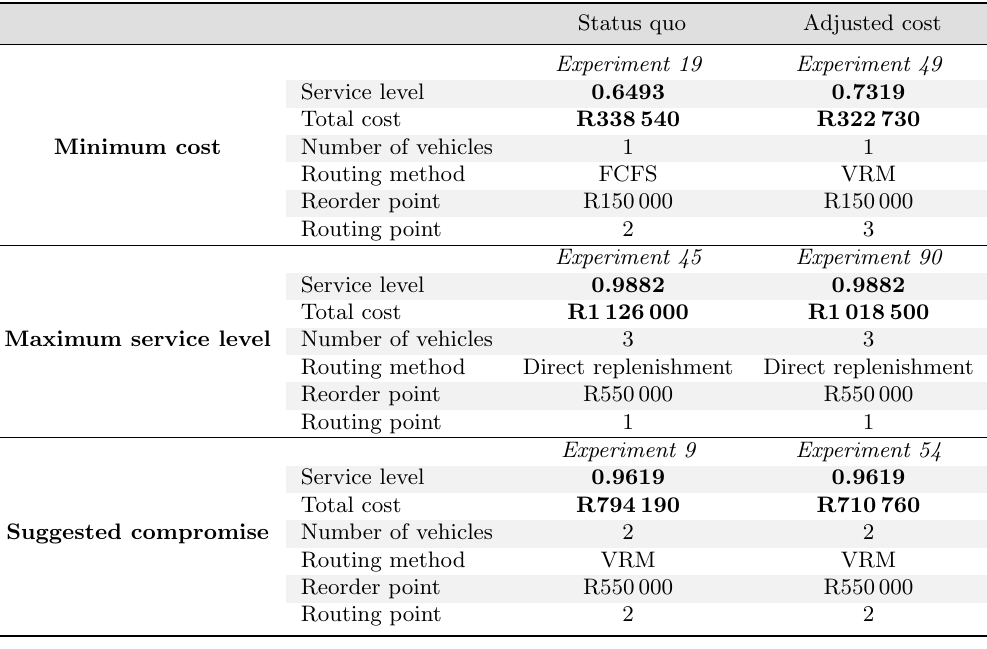
Table 4: When doing multi-objective optimisation, the decision maker is confronted with a set of good solutions, and choosing one for implementation is often done using business considerations. Here we show scenarios resulting in lowest cost, highest service level, and a good compromise. A lowest cost solution will result in a maximum service level of only 73%, while a highest service level choice will increase cost by more than three times. A suggested compromise shows a lower cost with a service level in excess of